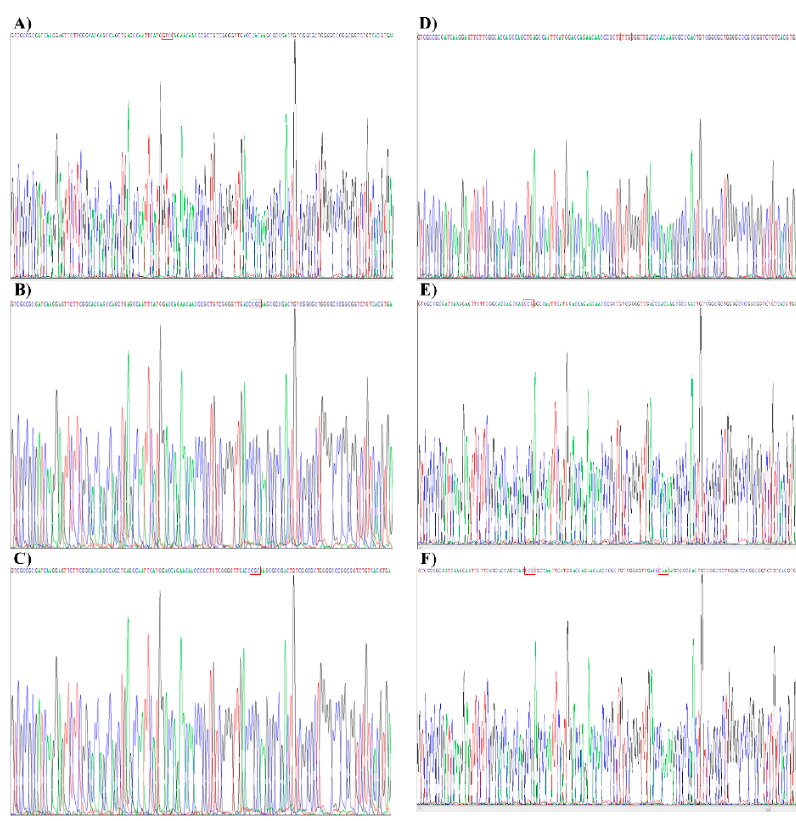
Figure 3. Examples of mutations identified by the sequencing analysis in the rpoB gene of TB in the clinical samples. ( A ) c516 (GAC → GTC); ( B ) c526 (CAC → CGC); ( C ) c531 (TCG → TTG); ( D ) c522 (TCG → TTG); ( E ) c511 (CTG → CCG); ( F ) c511 (CTG → CCG) and c526 (CAC → CAA).